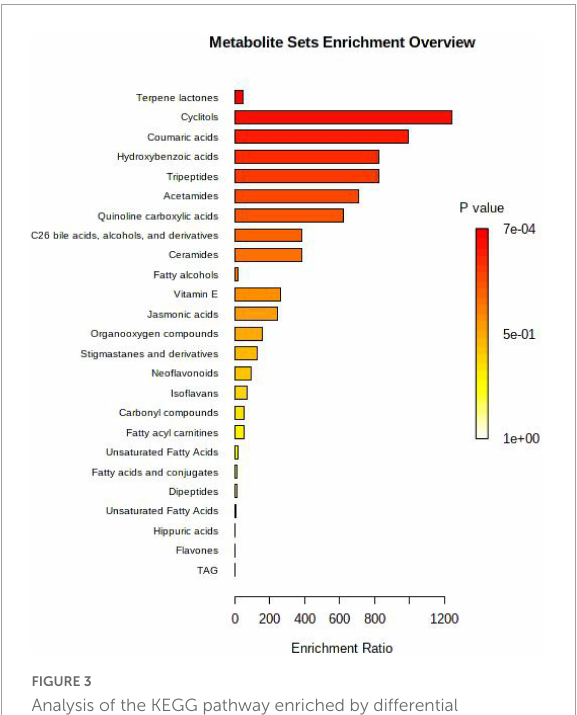
FIGURE3 Analysis of the KEGG pathway enriched by differential metabolites in the rumen.